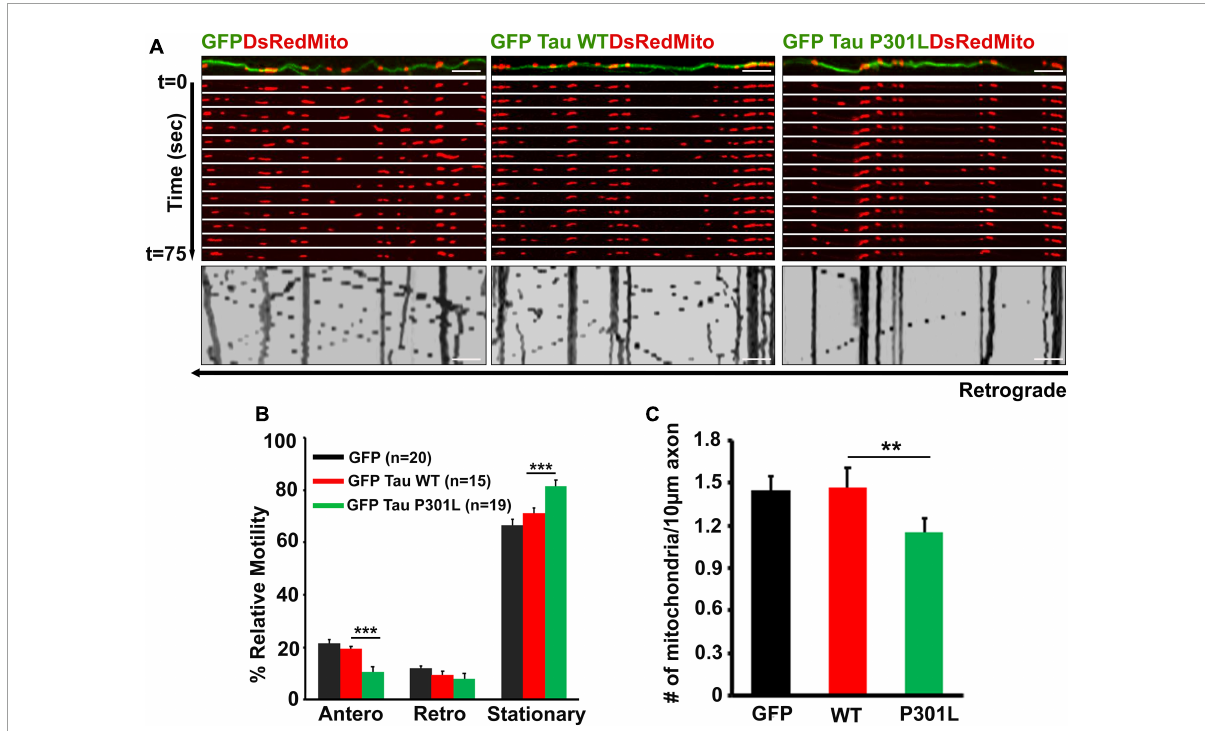
FIGURE1 Overexpression of P301L reduce anterograde mitochondrial transport in mouse primary cortical neurons: (A) Representative time-lapse images and kymographs of GFP, GFP-Tau WT, and GFP-P301L expressing neurons showing the selective reduction of anterograde mitochondrial transport in P301L expressing neurons, but retrograde transport remains unaltered. Kymographs provide a two-dimensional representation of time-lapse imaging. In kymograph, stationary mitochondria are represented by vertical lines, while diagonal lines represent motile populations. Diagonal lines moving towards the left represent retrograde movement, whereas lines moving towards the right represent anterograde transport. (B) Mitochondrial motility in each direction was quantified and represented as % relative motility. (C) Quantitative analysis showing the reduction of mitochondria density in axons of P301L neurons. The number of mitochondria along the axons was counted and represented as the number of mitochondria per 10 µ m axon. Data were obtained from three independent experiments. Number of cells used in the study are: GFP ( n = 20 neurons; GFP Tau WT ( n = 15); GFP P301L Tau ( n = 19); (n) from three independent experiments. Scale bar = 5 µ m. Error bars represent SEM. *** P < 0.001, ** P < 0.01.